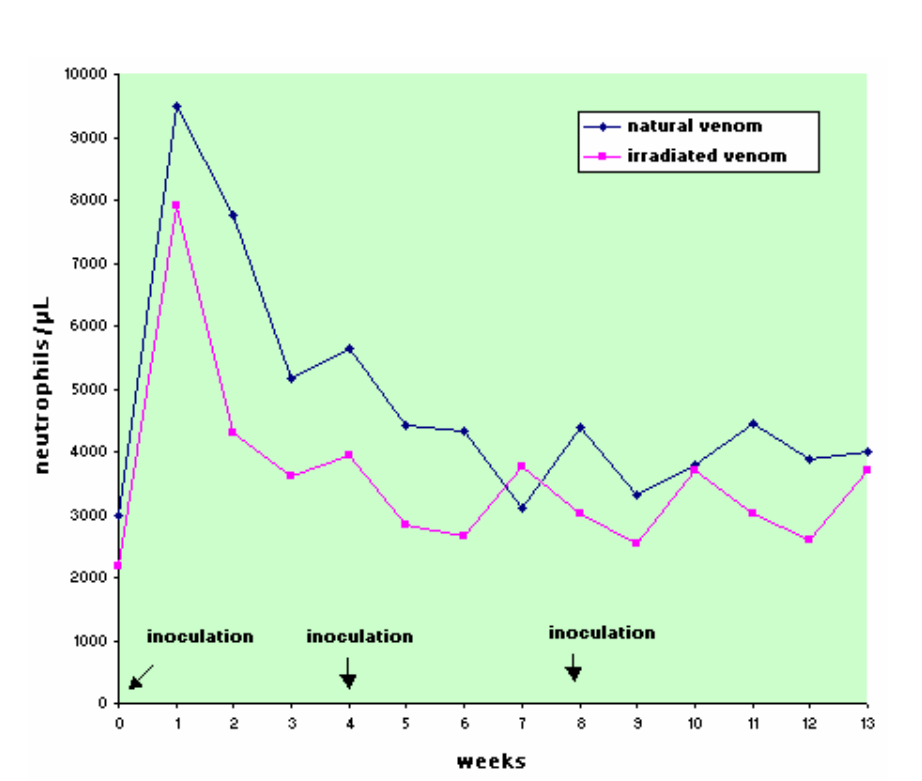
Figure 2 . Means of neutrophils count using sheep (n=12) sera inoculated with natural (NV) -irradiated (IrV) crotalic and Cobalt 60